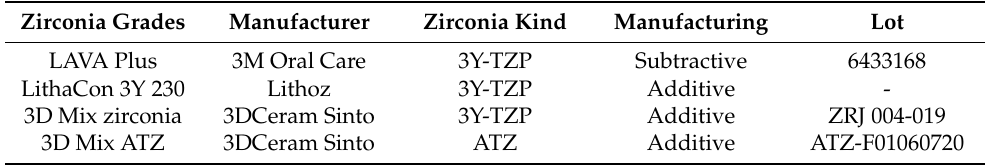
Table 1. Details of the zirconia ceramics